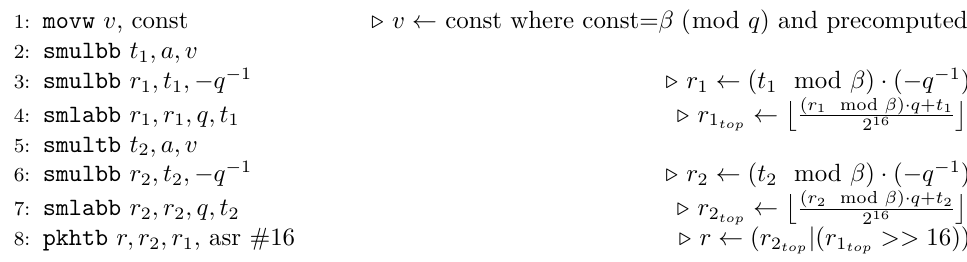
Algorithm 12 Signed Montgomery reduction on packed argument using Montgomery factor β = 2 16